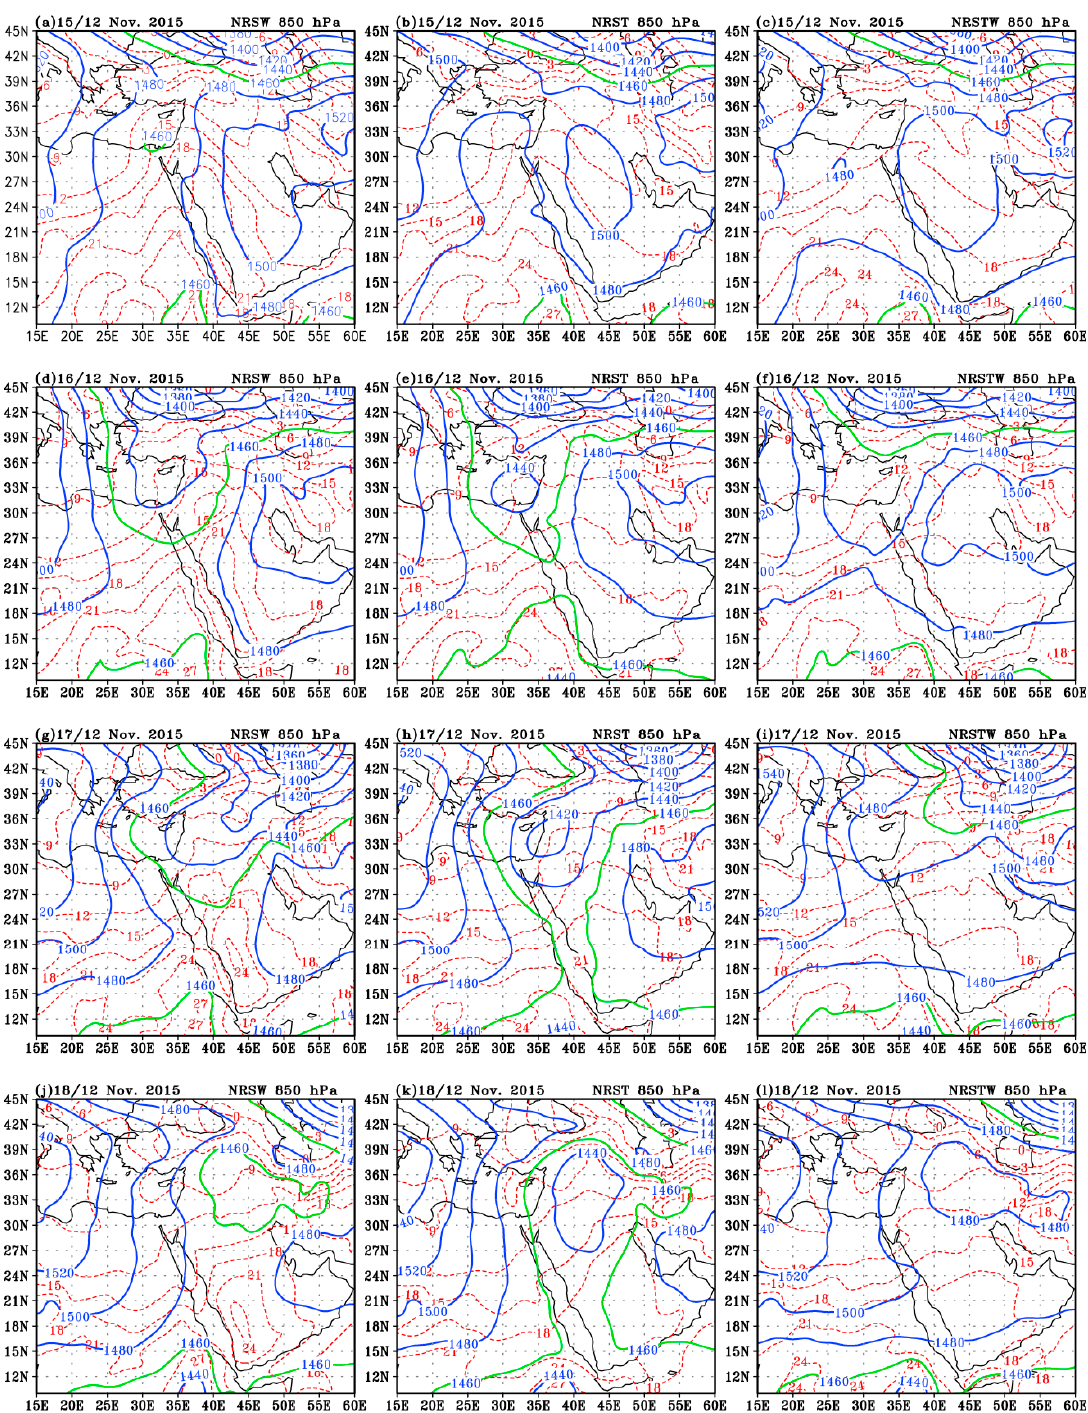
Figure 11. 850 hPa geopotential height with 20 m contour intervals (blue and green solid lines) along with the temperature (red dashed lines) every 3 °C from the NRSW ( a , d , g , j ), the NRST ( b , e , h , k ), and the NRSTW ( c , f , i , l ) at 12Z for the period of 15–18 November 2015.